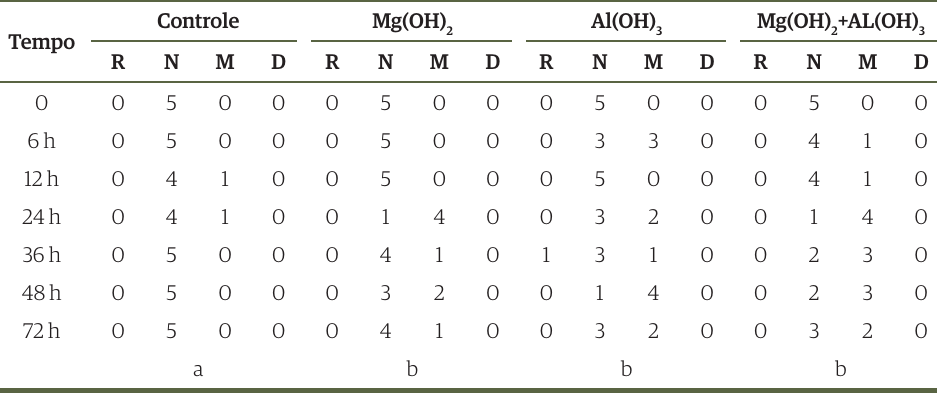
tabela 2. Frequência observada da consistência fecal, Ressecada (R), Normal (N), Amolecida (M), Diarreica (D) em cada um dos tratamentos administrados por sonda nasogástrica diluídos em 1 l de